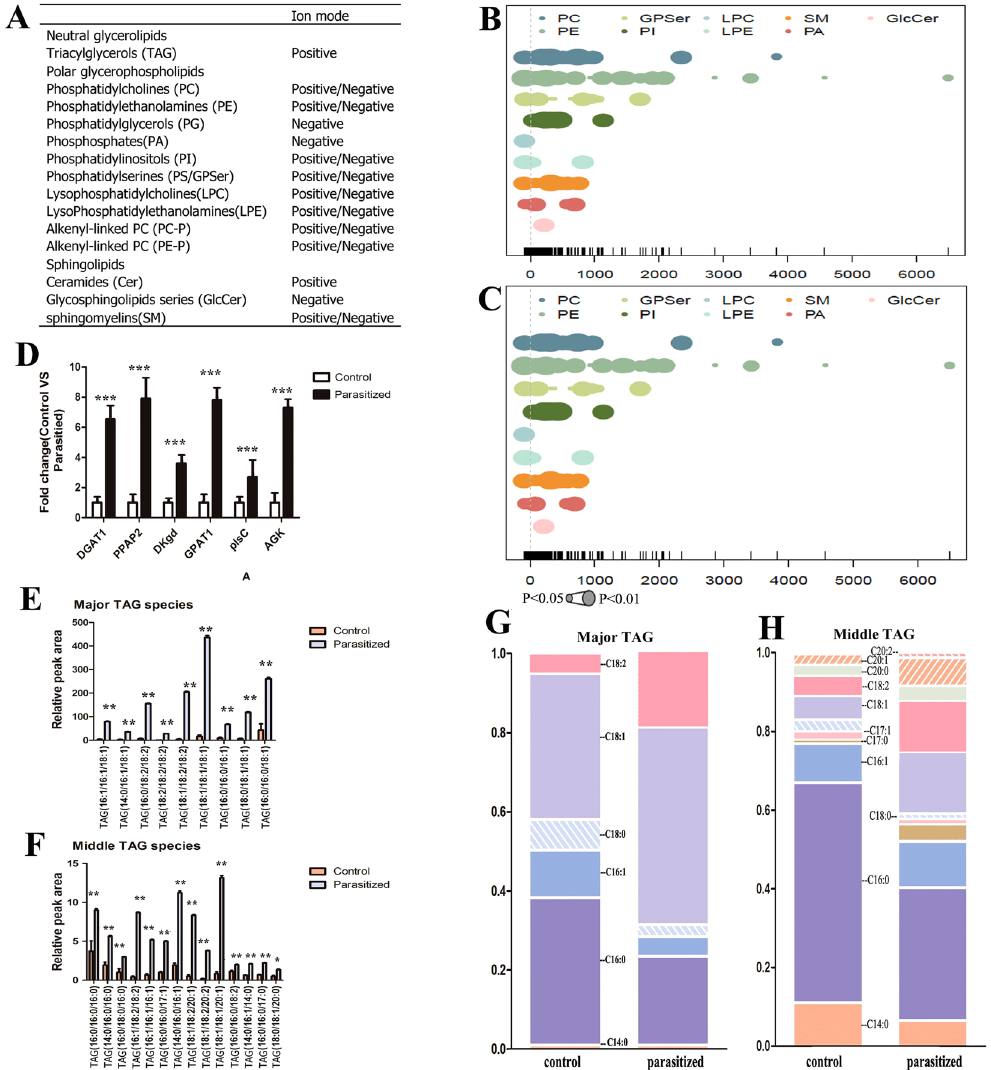
Figure 3. Changes in the Lipid Composition and Fatty acyl chains of triglycerides (TAG) in parasitized aphids. Lipid classes identified in lipidomics experiments and their abbreviations used in this paper. ( B , C ) Differences in the relative percentage of all quantified lipid species between parasitized and control aphids (POS and NEG). Each spot represents a lipid species, the spot size indicates significance, and the different colors represent different lipid species. n = 6/group. ( D ) Relative expression levels of selected genes involved in glycerolipid metabolism. Data are means ± SEM; n = 3/group. *** FDR < 0.001. ( E ) The relative peak area of quantified major TAG species in parasitized and control aphids. Data are means ± SEM; n = 6/group. ** p < 0.01. ( F ) The relative peak area of quantified middle TAG species in parasitized and control aphids. Data are means ± SEM; n = 6/group. * p < 0.05, ** p < 0.01. ( G , H ) Changes in glycerolipid base chemistry and fatty acyl chains of major TAG ( G ) and middle TAG ( H ) in parasitized and control aphids. Data are means ± SEM α n =